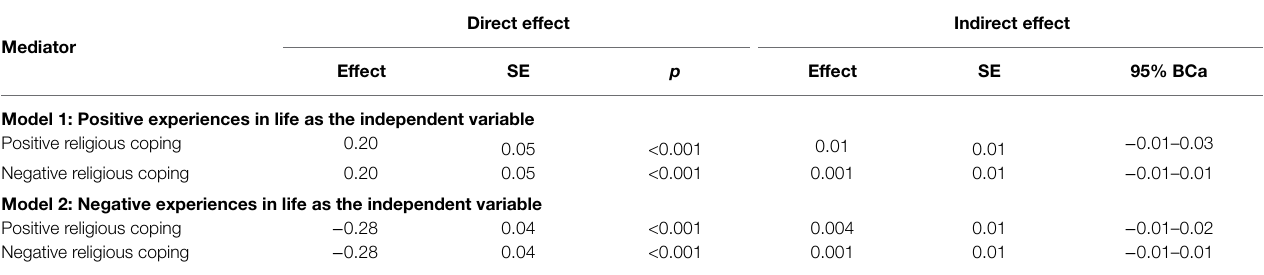
TABLE 5 | Mediation analysis: Direct and indirect effects of the associations between positive/negative religious coping in the relationship between positive/negative experiences in life and positivity.